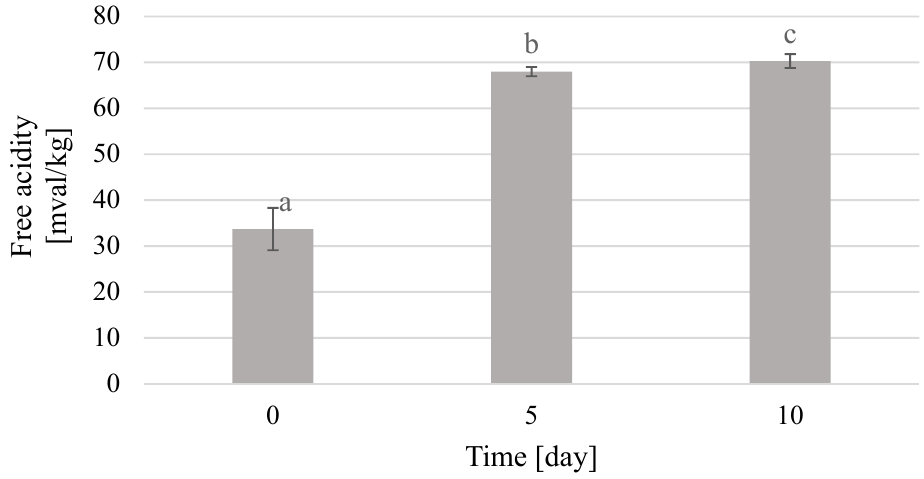
Figure 6. Changes in free acidity of beebread caviar during storage; p a-b = 0.00023; p b-c = 0.09126 .